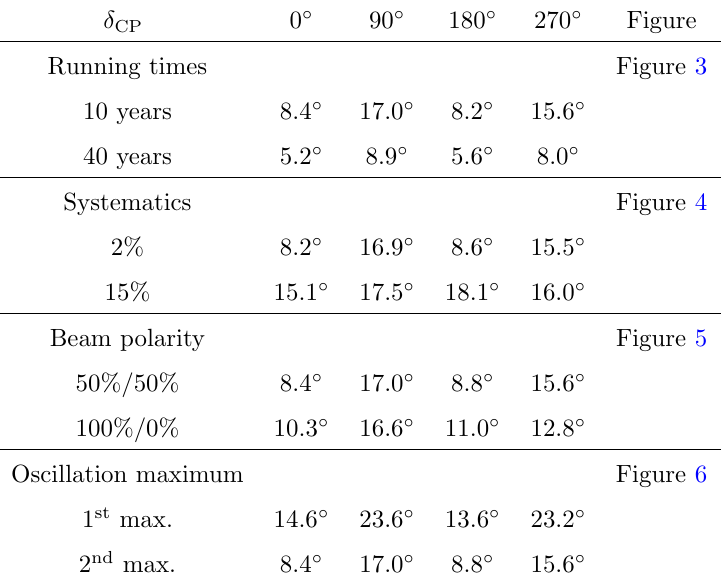
Table 3. The impact of statistical error, systematic uncertainties, changing the fraction of the positive/negative beam polarity in the total running time and adjusting the beam energy and baseline setup to match the (cid:12)rst and second oscillation maximum on (cid:1) (cid:14) CP for (cid:14) CP = 0 (cid:14) , 90 (cid:14) , 180 (cid:14) and 270 (cid:14) at 1 (cid:27) con(cid:12)dence level. The values are shown for the normal mass ordering. The (cid:12)nal column shows references to the relevant